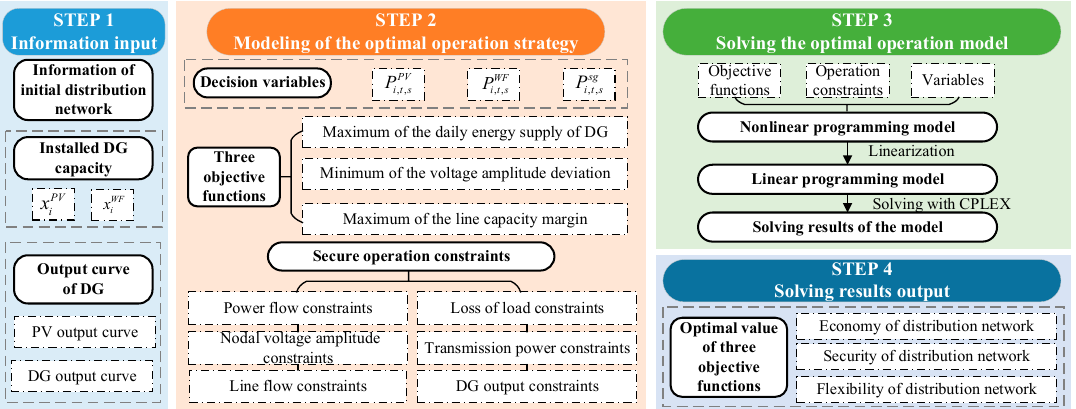
Figure 1. Methodology diagram flows of the multi-objective optimization model. Note: DG = distributed generation.